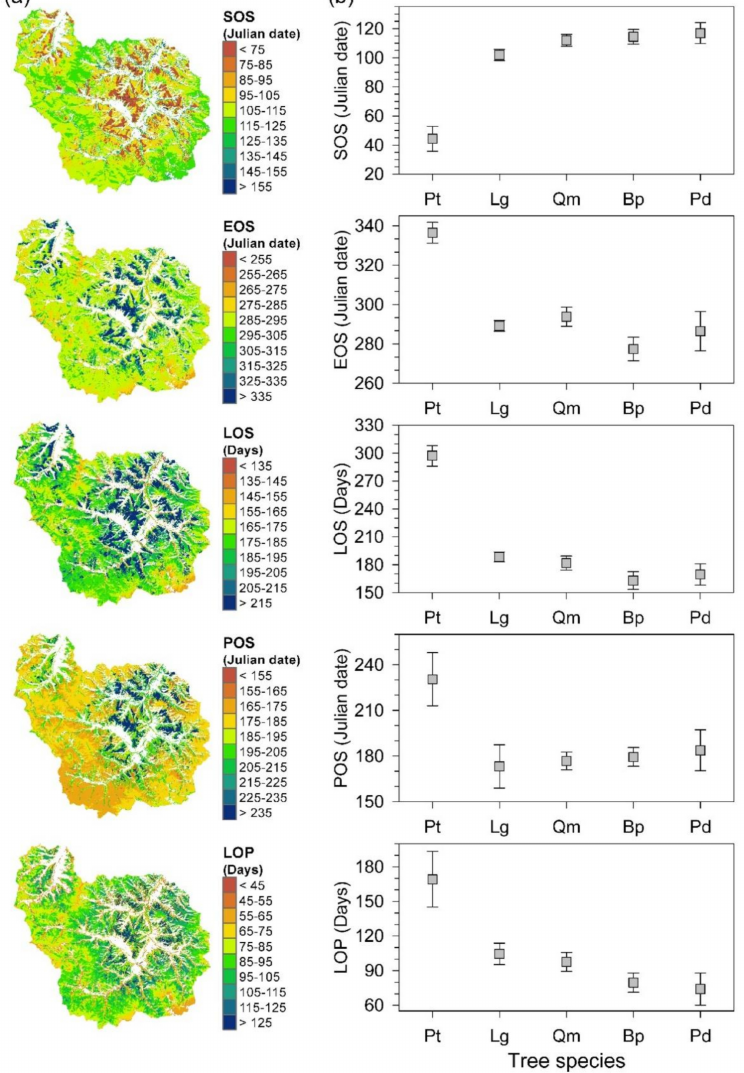
Figure 6. The landscape patterns of five phenological metrics in study region, the SOS (start of growing season, Julian date), EOS (end of growing season, Julian date), LOS (length of season, days), POS (peak of growing season, Julian date), and LOP (length of peak, days) from the top to bottom respectively ( a ), and the comparisons of SOS, EOS, LOS, POS, and LOP among five tree species (Pt, Lg, Qm, Bp, and Pd) from the top to bottom ( b ). The five metrics are significant di ff erent among various species ( p <